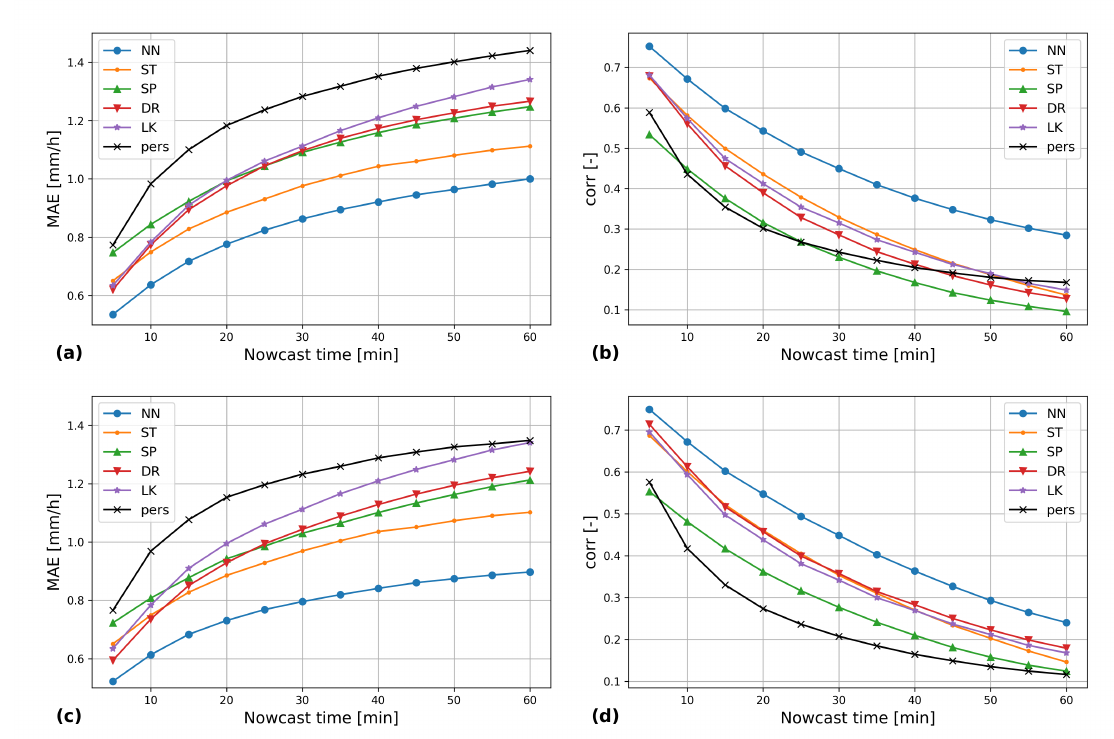
Figure 7. As in the previous figure for MAE and Pearson’s correlation coefficient. First row of plots (boxes ( a ) and ( b )) shows results evaluated in the domain DS, second row (boxes ( c ) and ( d )) those in